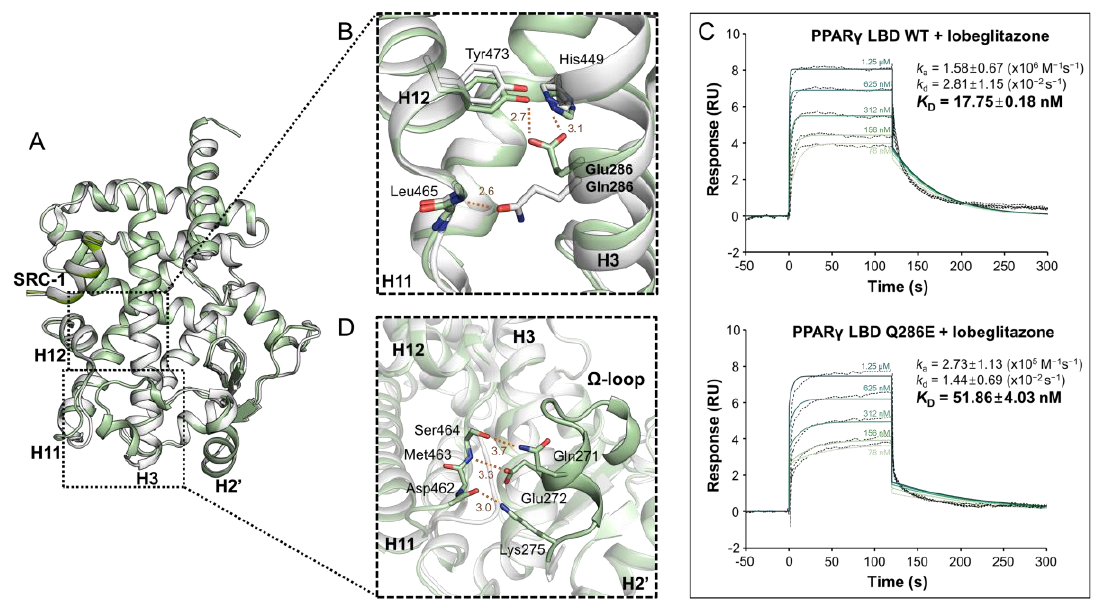
Figure 2. Overall structures of PPARγ LBD WT and Q286E. ( A ) Superposition of apo PPARγ LBD WT (white) and Q286E (pale green) structures. Overall structures are displayed as cartoon representations. ( B ) The region of helices H3, H11 and H12 is magnified and depicted by a black-dashed box. Stick representations are shown for the backbone of Leu465 and the side chains of Tyr473, His449, Glu286 of Q286E and Gln286 of WT. ( C ) Surface plasmon resonance (SPR) analyses of binding affinities for lobeglitazone of PPARγ LBD WT (upper) and Q286E (bottom). SPR sensorgrams show the binding of lobeglitazone at increasing concentrations to immobilized proteins of PPARγ LBD WT and Q286E. K D values shown on the right side are calculated from fitting (colored lines) onto the responses (dotted lines in black color). The data of k a , k d and K D are presented as the mean ± SD of two independent experiments. ( D ) The region of Ω-loop is magnified and depicted by a black-dashed box. Stick representations are shown for the side chains of Gln271, Glu272, Lys275 and Ser464 and the backbones of Asp462 and Met463 in the PPARγ Q286E structure. Hydrogen bonds are depicted by orange dashed lines and labeled with distances in Å. Oxygen and nitrogen atoms are colored in red and blue,